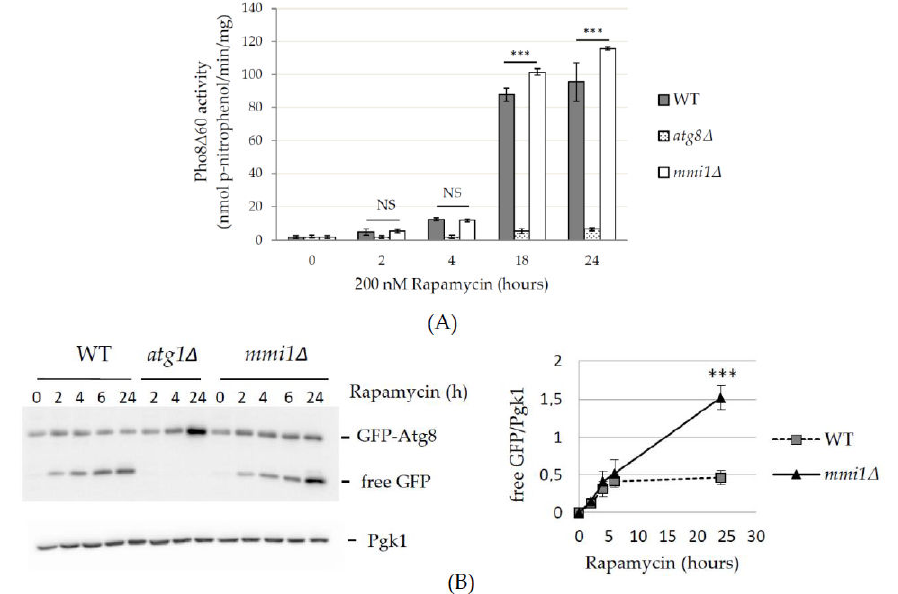
Figure 2. Non-selective autophagy is promoted in the mmi1 ∆ strain after prolonged incubation with rapamycin. ( A ) Exponentially growing WT, atg8 ∆ , and mmi1 ∆ cells expressing Pho8 ∆ 60 (OD 600 ≈ 0.8) were treated with rapamycin 200 nM. Samples were taken at indicated time points, proteins extracted, and the specific Pho8 ∆ 60 activity was determined. Results are means ± SD of two independent experiments performed in duplicates (n = 4). The statistical evaluation was performed by using two way analysis of variance (ANOVA). NS; not significant; *** p < 0.001. ( B ) Western blot detection of GFP-Atg8 cleavage in WT, atg1 ∆ , and mmi1 ∆ cells after rapamycin addition. Cells expressing GFP-Atg8 were grown until log phase (OD ≈ 0.8) and then rapamycin was added to a final concentration 200 nM. At indicated time points proteins were extracted and the protein lysates were examined by Western blot. Pgk1 was used as a loading control. Quantification of the blots is presented to the right. GFP ratio (free GFP / Pgk1) was calculated. *** p < 0.01. Error bars reflects SD from three independent